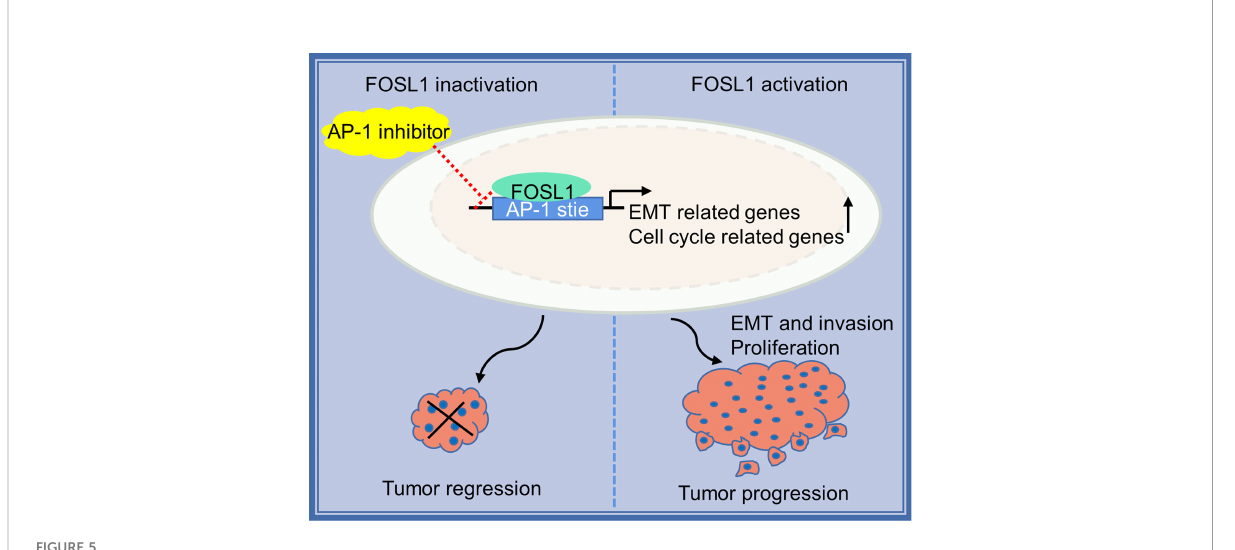
FIGURE 5 Proposed model for FOSL1 in AM